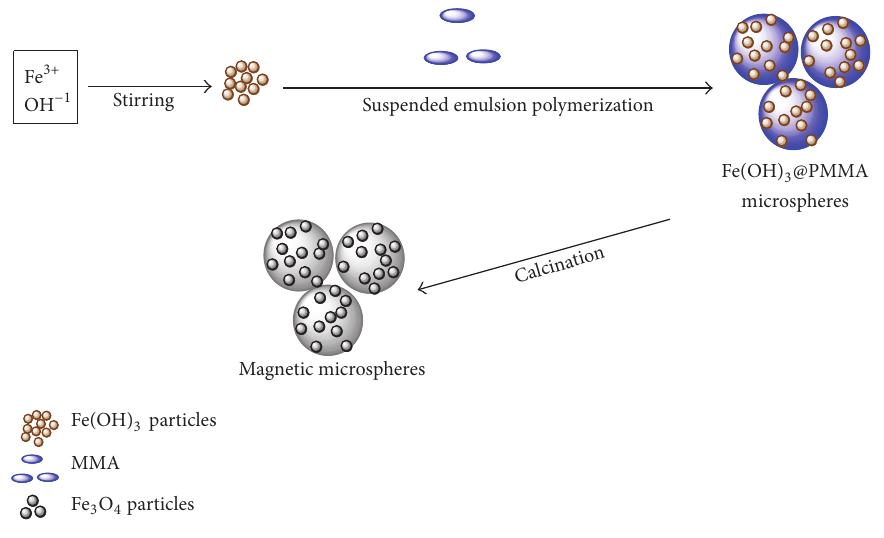
Figure 1: Schematic illustration of the synthesis process of magnetic